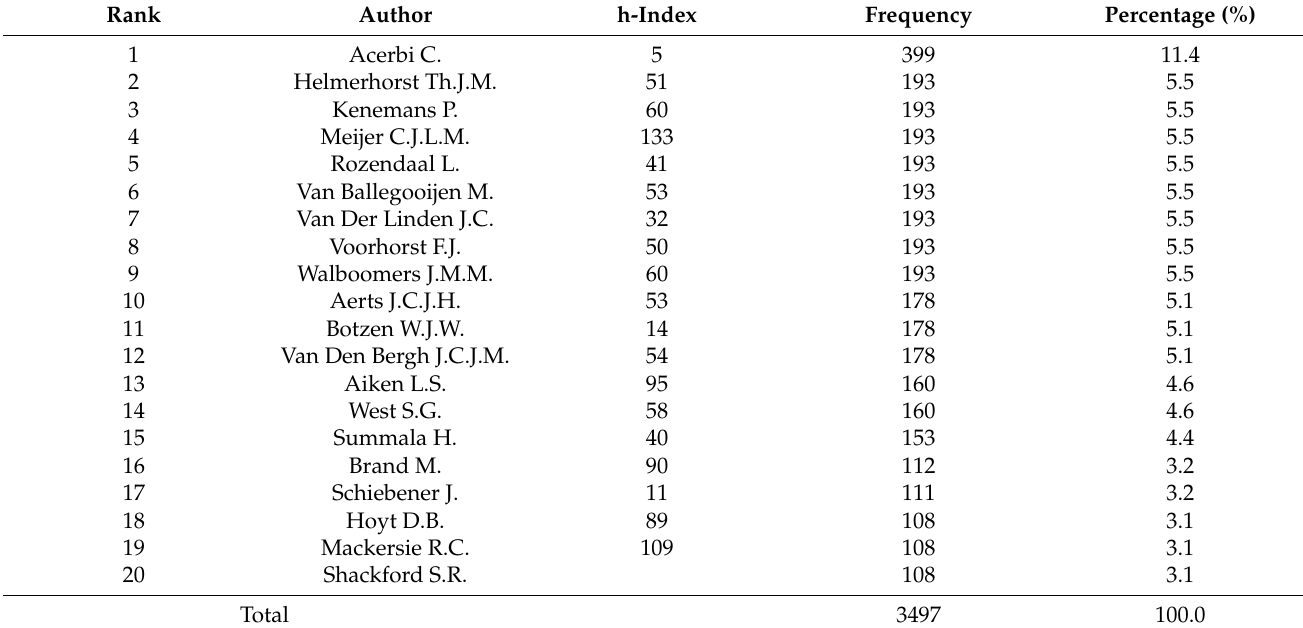
Table 5. Top 20 authors of related